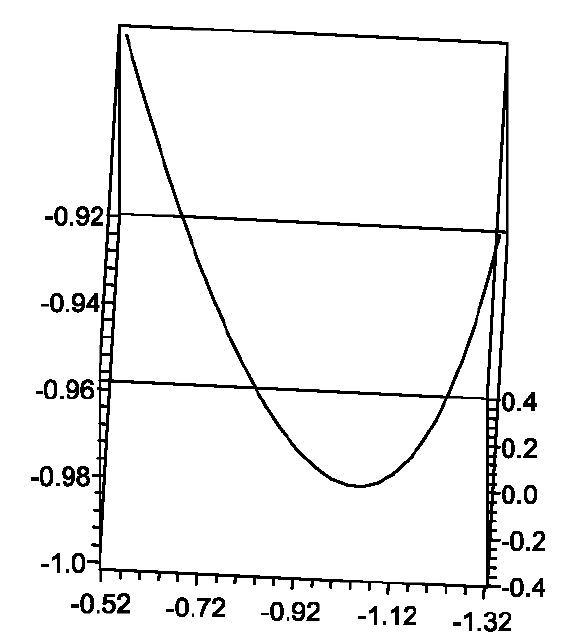
Figure 5. the singular locus of PN H